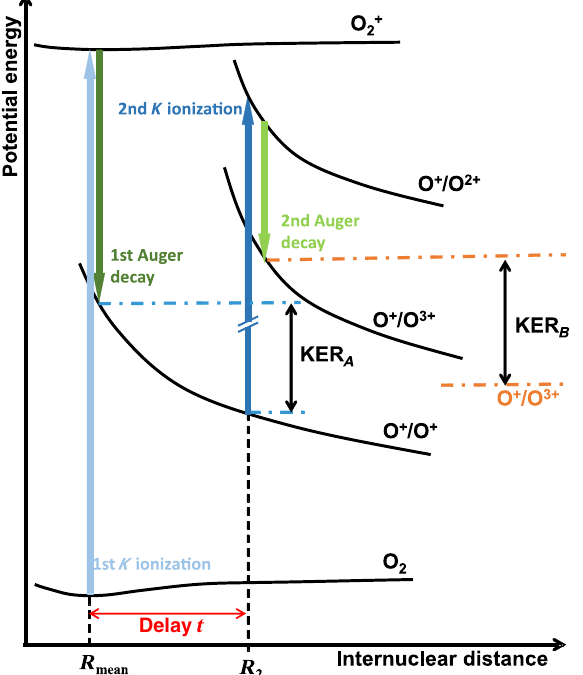
FIG. 2. Schematic of the modeled internuclear distance ex- traction. After initial K -shell ionization of the neutral molecule at the mean internuclear distance R , an Auger decay of the mean singly charged molecular ion triggers a Coulomb explosion along the repulsive O þ = O þ curve. The second K -shell electron is ionized at internuclear distance R 2 after a delay t . The molecule is now in an O þ = O 2 þ state, which — within our simplified model — it immediately leaves after emission of a second Auger electron. The Coulomb explosion continues along the O þ = O 3 þ repulsive þ curve. The total kinetic energy of the ions KER ¼ KER A KER is measured in our B